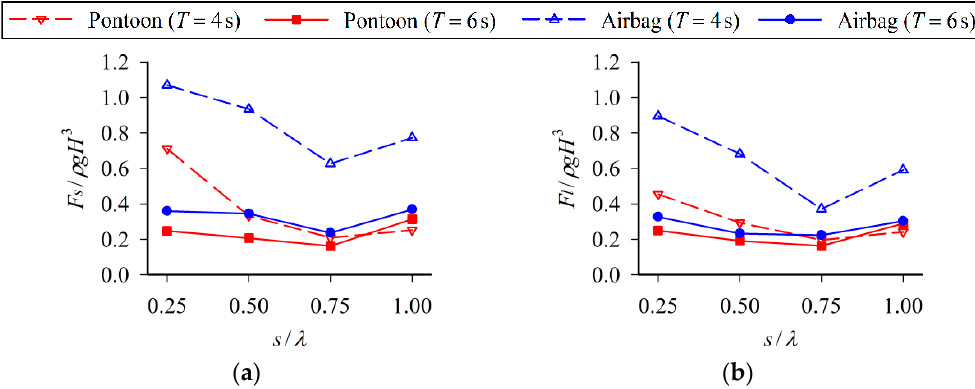
Figure 15. Comparison of the mooring force of the double-row floating breakwater with different separation distance s / λ : ( a ) Seaward side F s ; ( b ) Leeward side F l .